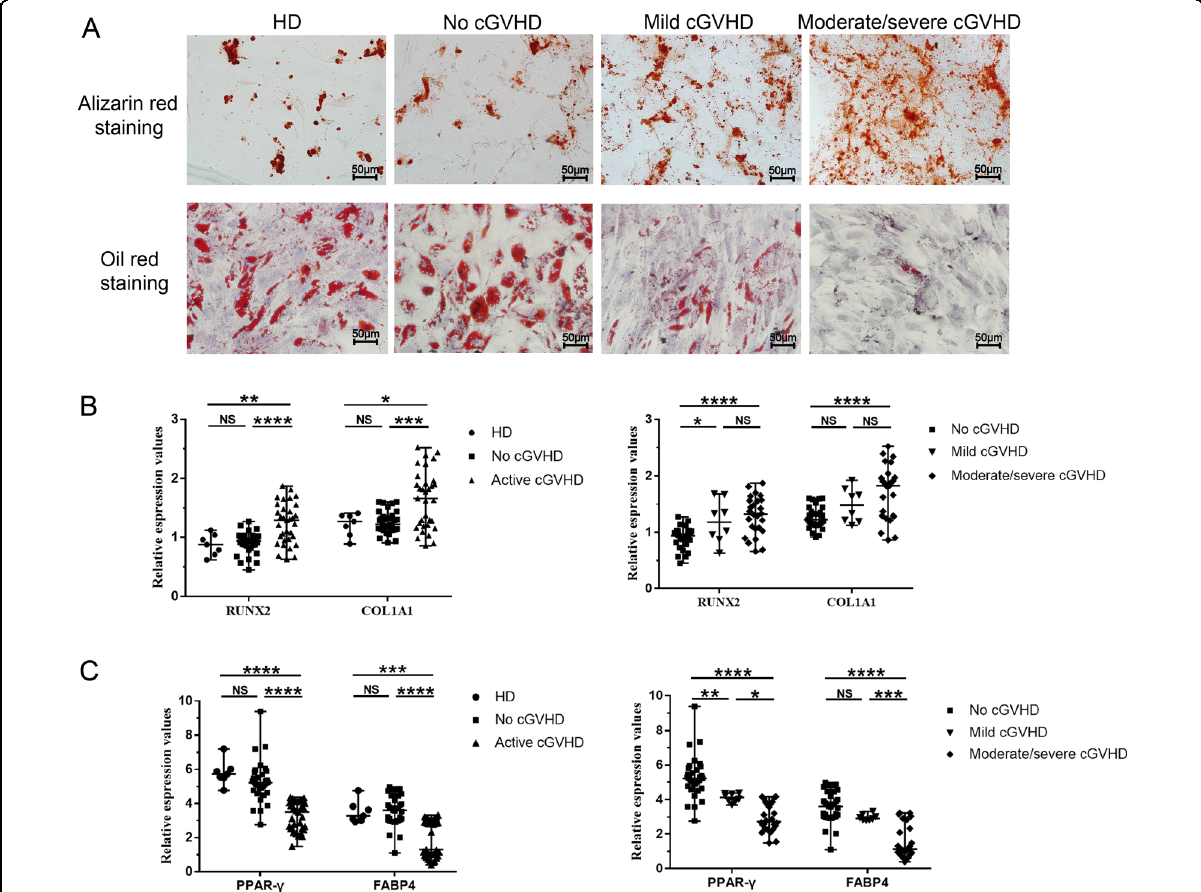
Fig. 3 Increased osteogenic differentiation capacity and decreased adipogenic differentiation capacity in MSCs from patients with active cGVHD. A Osteogenic differentiation (above) of HD-MSCs, no cGVHD-MSCs, mild cGVHD-MSCs and moderate/severe cGVHD-MSCs was demonstrated by alizarin red staining, Orange-red represents calcium nodules. Adipogenic differentiation (under) of HD-MSCs, no cGVHD-MSCs, mild cGVHD-MSCs, and moderate/severe cGVHD-MSCs was detected by Oil Red O staining, and red represents lipid droplets. Scar bar = 50 μ m. B Gene expression of osteogenic markers RUNX2 and COL1A1 in HD-MSCs, no cGVHD-MSCs, active cGVHD-MSCs, and different severities of cGVHD-MSCs. C Gene expression of adipogenic markers PPAR- γ and FABP4 in HD-MSCs, no cGVHD-MSCs, active cGVHD-MSCs, and different severities of cGVHD- MSCs. HD-MSCs ( n = 7), no cGVHD-MSCs ( n = 33), mild cGVHD-MSCs ( n = 8), and moderate/severe cGVHD-MSCs ( n = 25). Results were normalized to the expression of glyceraldehyde 3-phosphate dehydrogenase (GAPDH). Black bars in each fi gure represent the median ± range. NS, not signi fi cant. * P < 0.05, ** P < 0.01, *** P < 0.001, and **** P <